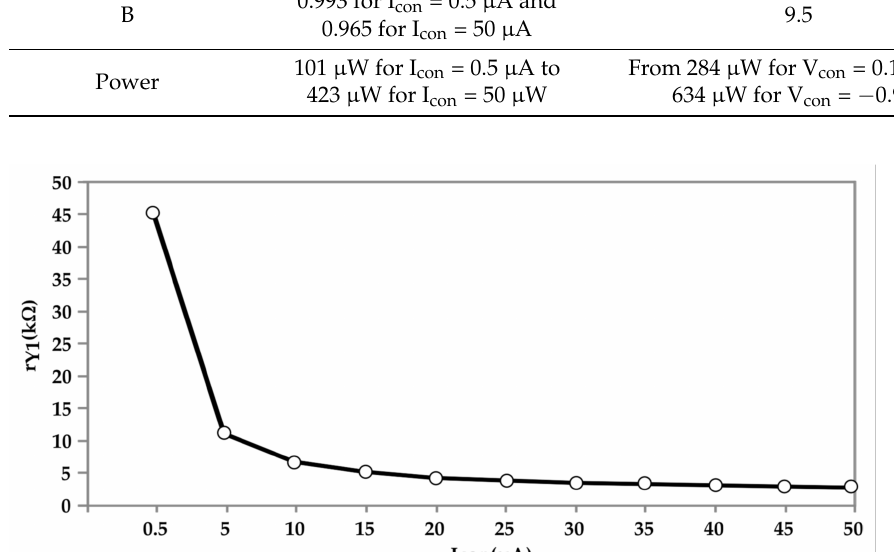
Figure 6. Variation of r Y1 as a function of I con for CVCII 1+ .